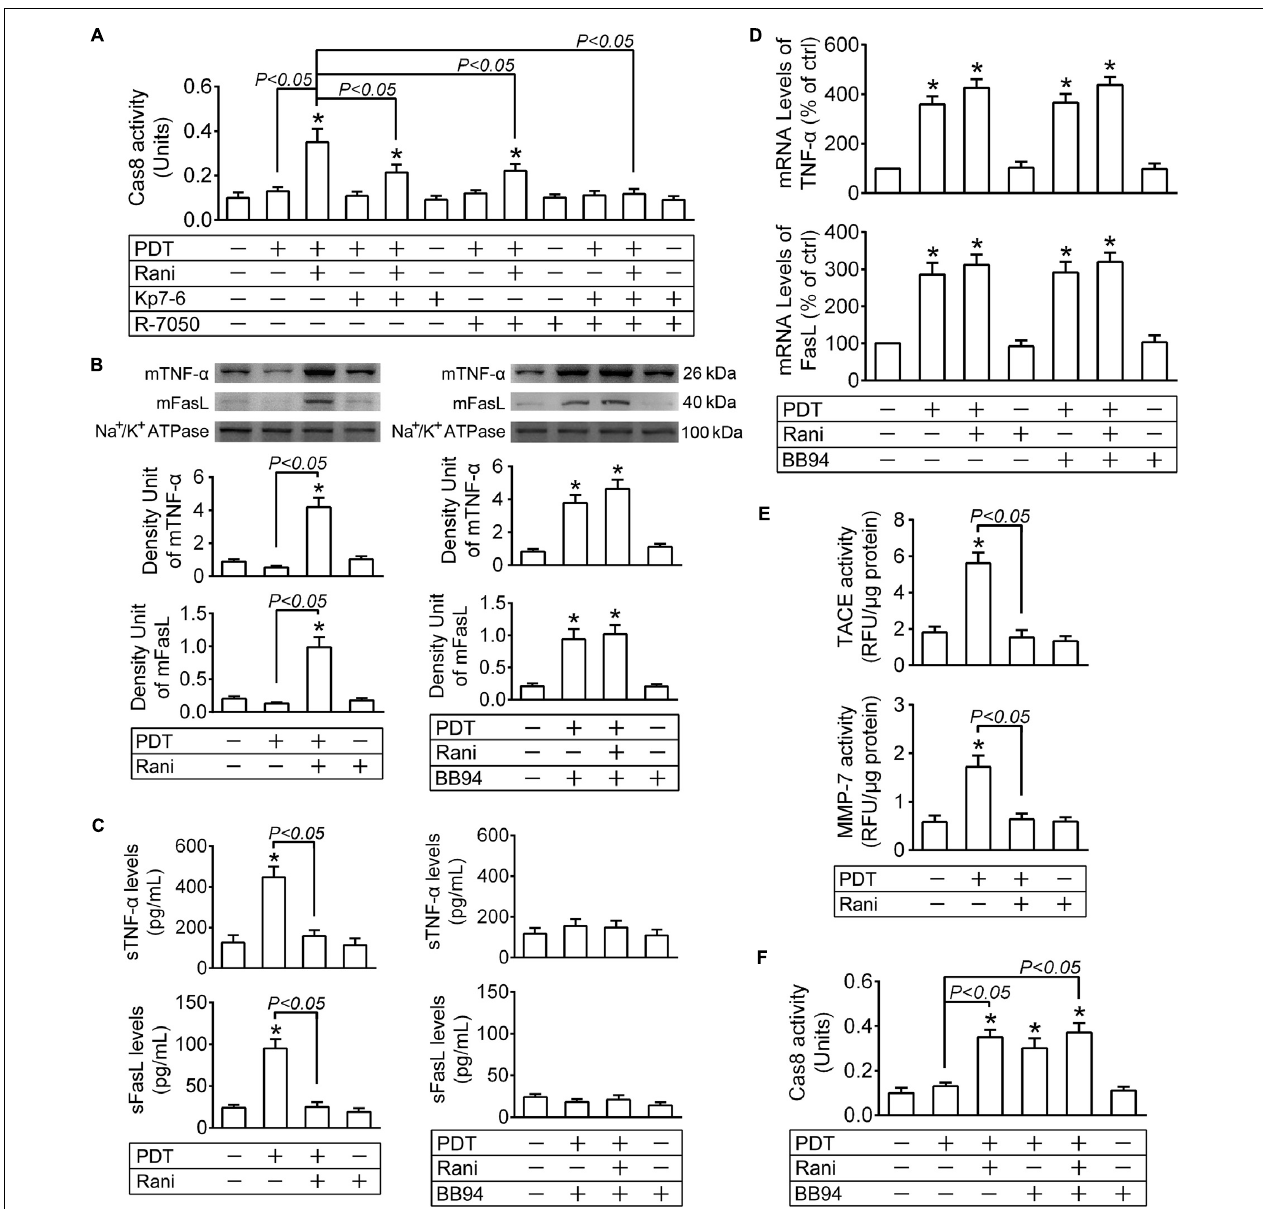
FIGURE 5 | Pre-treatment with rani activates cas8 in PDT-exposed cells through preventing matrix metalloprotease (MMP)-mediated cleavage of death ligands. RF/6A cells were exposed to PDT, rani was applied to the cells at 6 h before PDT, and Kp7-6 (a specific Fas/FasL antagonist), R-7050 (a selective TNF- α receptor antagonist) and Batimastat (BB-94, a broad spectrum MMP inhibitor) were administrated right after PDT. Various detections were performed at 12 h after PDT. (A,F) Cas8 activity in the cells was measured with a cas8 colorimetric activity assay kit. (B) The plasma membrane proteins were extracted and purified, and the levels of membrane-bound ligands (mFasL and mTNF- α ) were detected by immunoblotting. (C) The levels of soluble ligands (sFasL and sTNF- α ) in cell culture medium supernatants were measured by ELISA. (D) The mRNA levels of FasL and TNF- α in RF/6A cells were tested by real time PCR. (E) MMP-7 activity in cell culture medium supernatants and TNF- α converting enzyme (TACE) activity in plasma membrane fraction were detected with SensoLyte 520 MMP-7 or TACE ( α -Secretase) Activity Assay Kit. n = 4; * P < 0.05, compared with the